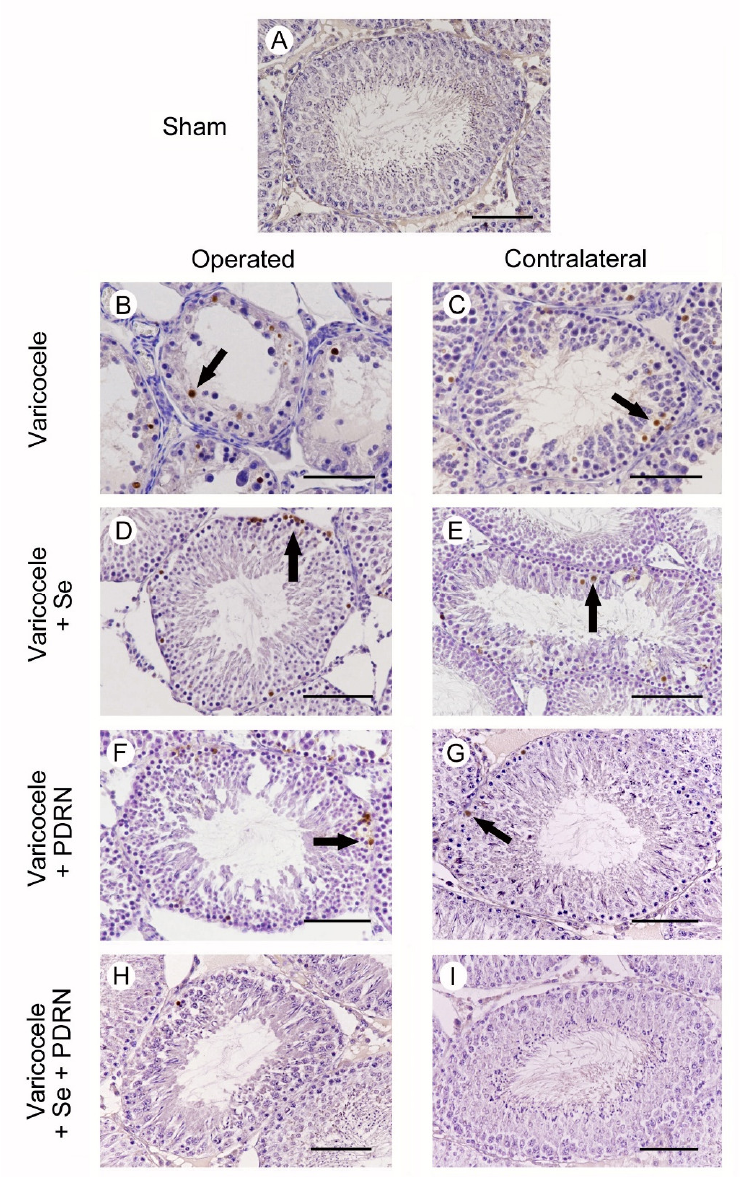
Figure 4. Assessment of apoptosis in the testes with TUNEL staining technique from rats of sham, varicocele, varicocele contralateral, varicocele plus Se (0.4 mg/kg/day i.p.), varicocele plus Se contralateral, varicocele plus PDRN (8 mg/kg/day i.p.), varicocele contralateral plus PDRN, varicocele plus Se plus PDRN, varicocele contralateral plus Se plus PDRN groups. ( A ): In sham rats, no TUNEL positive cells can be observed. ( B ): In the testes of varicocele rats, a large number of TUNEL-positive germ cells (arrow), placed along the wall of the tubules, are observed. ( C ): In the contralateral testes of the same rats, some isolated TUNEL-positive germ cells are present in the peripheral part of the seminiferous tubules (arrow). ( D ): In varicocele rats treated with Se, many TUNEL-positive cells are present in the periphery of the seminiferous tubules (arrow). ( E ): In the contralateral testes of the same group, some TUNEL-positive cells are located in the external part of the tubules (arrow). ( F ): In the testes of varicocele rats treated with PDRN, the number of TUNEL-positive cells is reduced, and they are located along the peripheral part of the tubules (arrow). ( G ): In contralateral testes of the same group, only a few TUNEL-positive cells (arrow) are present in the seminiferous epithelium. H, I: In the seminiferous tubules of both operated and contralateral testes of varicocele rats treated with Se plus PDRN, very rare or no TUNEL-positive cells are observed. (Scale bar: 50 µ